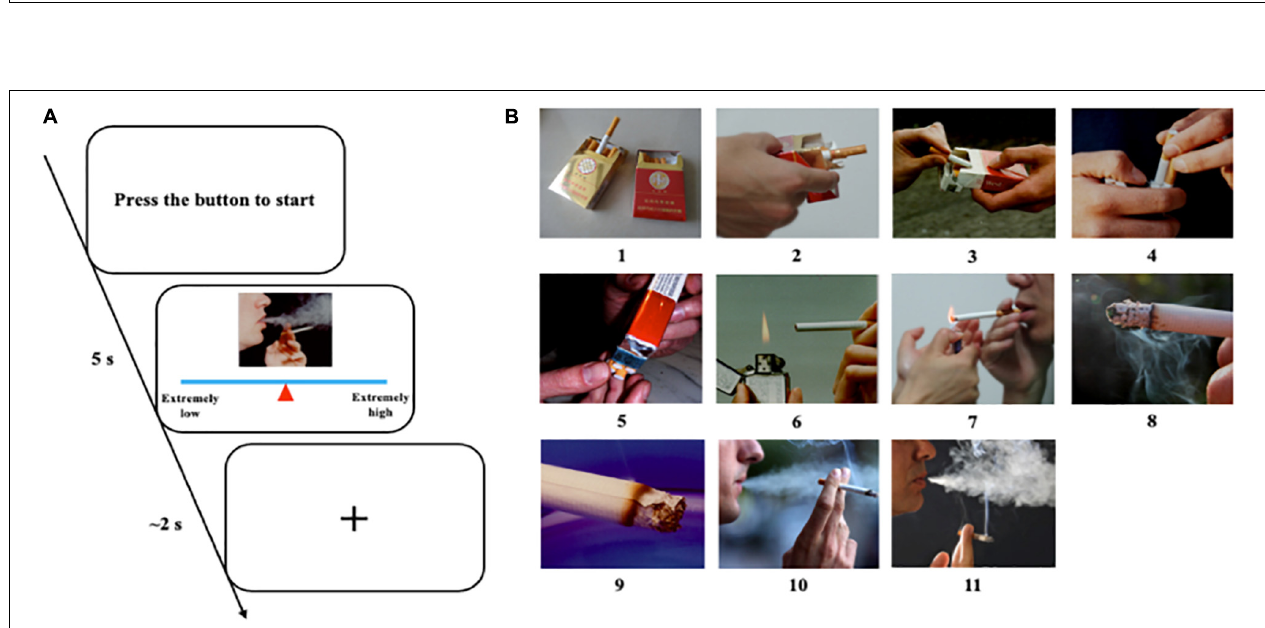
FIGURE 1 | Two phases for one neurofeedback visit: offline model construction and real-time neurofeedback training. (A) Offline classifier construction phase. (B) Real-time EEG neurofeedback training phase. (C) Experimental protocol in one visit. NF, neurofeedback.